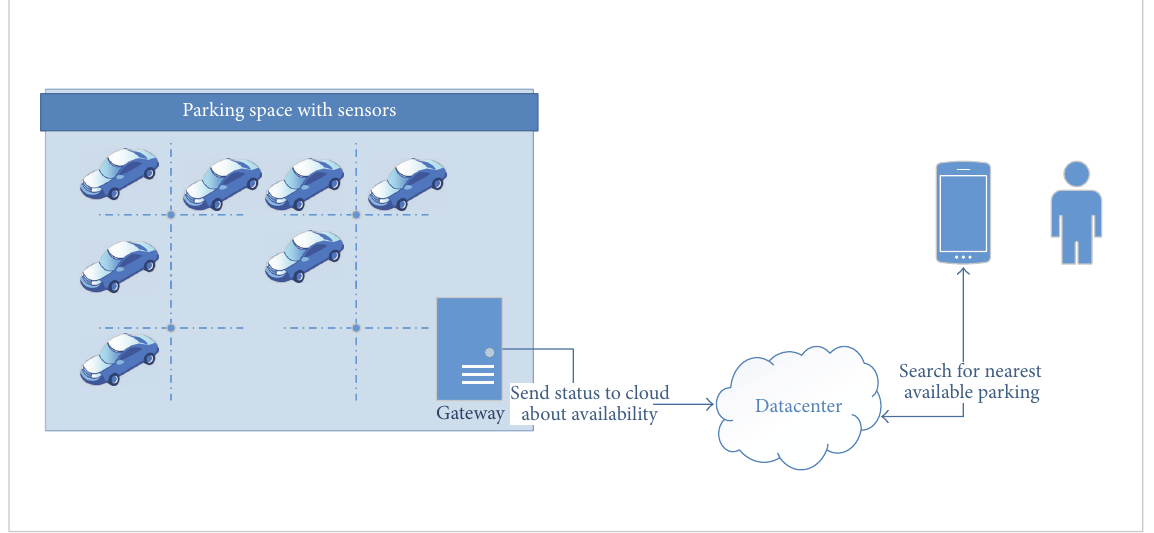
Figure 9: Block diagram of a smart parking